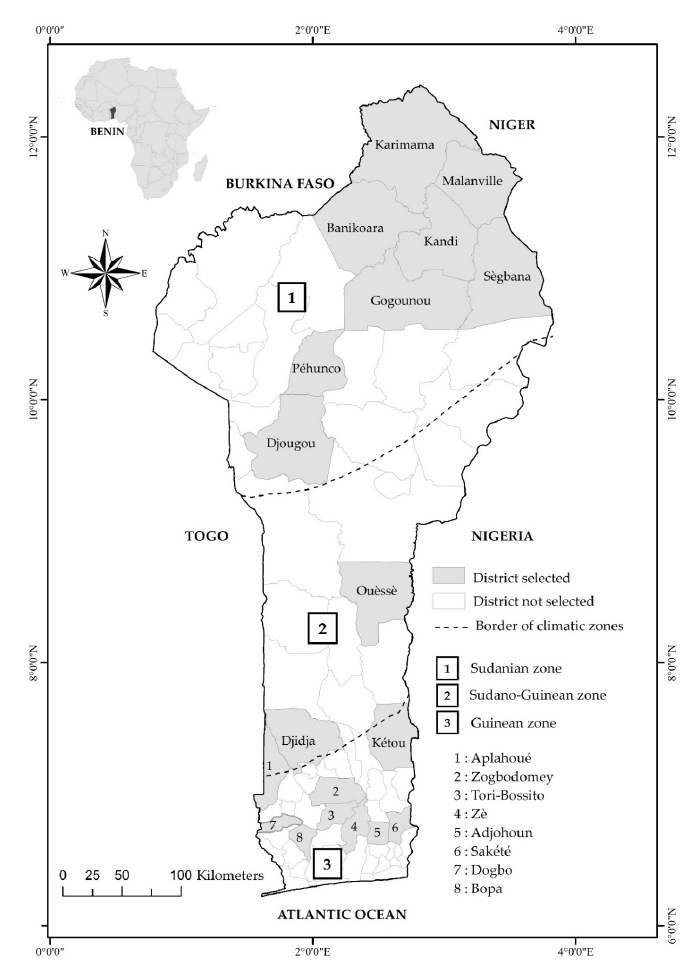
Figure 1. Map of Benin showing the location of the surveyed